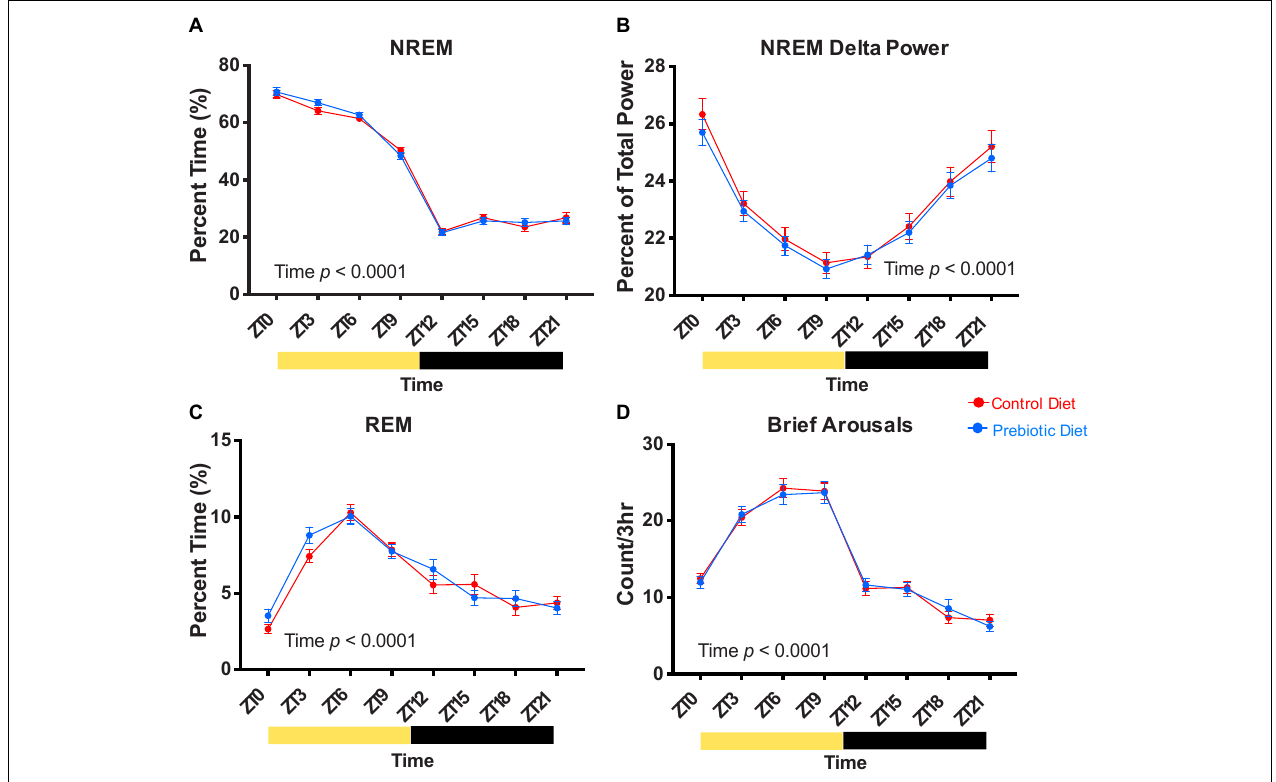
FIGURE 3 | The prebiotic diet does not impact baseline sleep. Two weeks after EEG/EMG surgery, after six total weeks on diet, 24 h of baseline sleep was recorded. (A) NREM sleep, (B) NREM EEG delta power, (C) REM sleep, and (D) brief arousals are reported in 3-h bins. Yellow bars below the x axes represent times where the lights were on, while black bars represent times the lights were off. Mixed effects modeling was performed to test for effects of time, diet, and any interactions. Data are mean + SEM. n = 38–40/group. EEG, electroencephalogram; NREM, non-rapid eye movement; REM, rapid eye movement; ZT, Zeitgeber time.